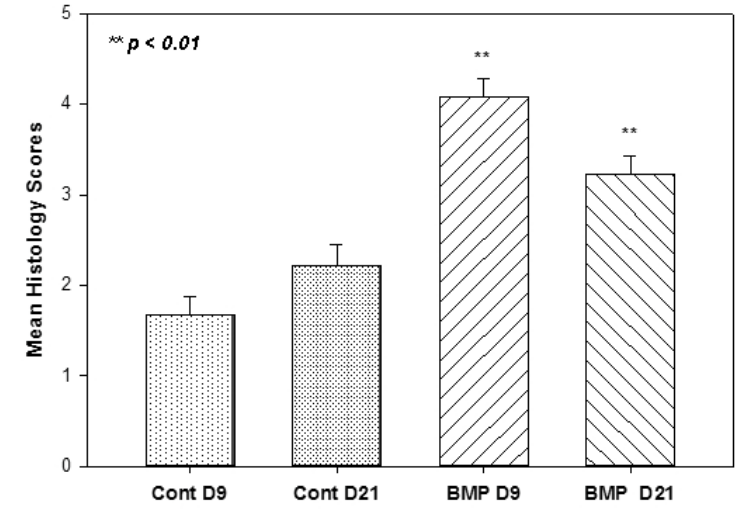
Figure 4. Average histology healing scores among non-coated (control) and BMP2-coated (BMP) at day 9 (D9) and day 21 (D21) after groups at day 9 (D9) and day 21 (D21) after surgery.